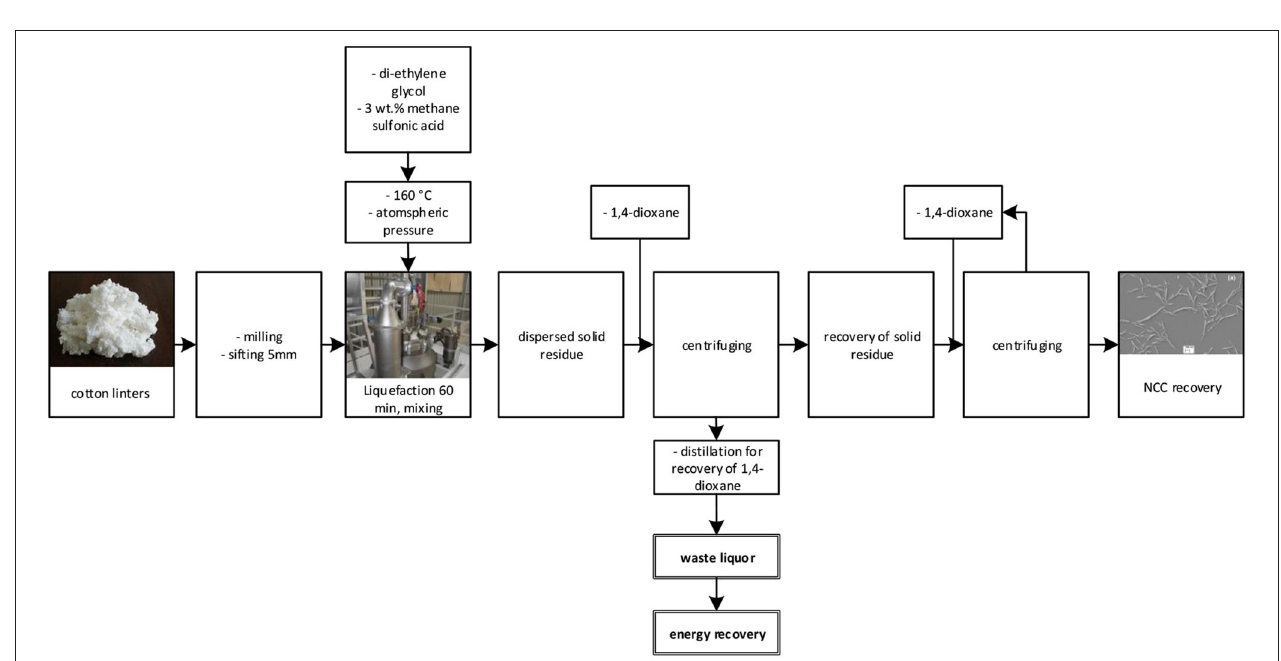
FIGURE 2 | Waste liquor